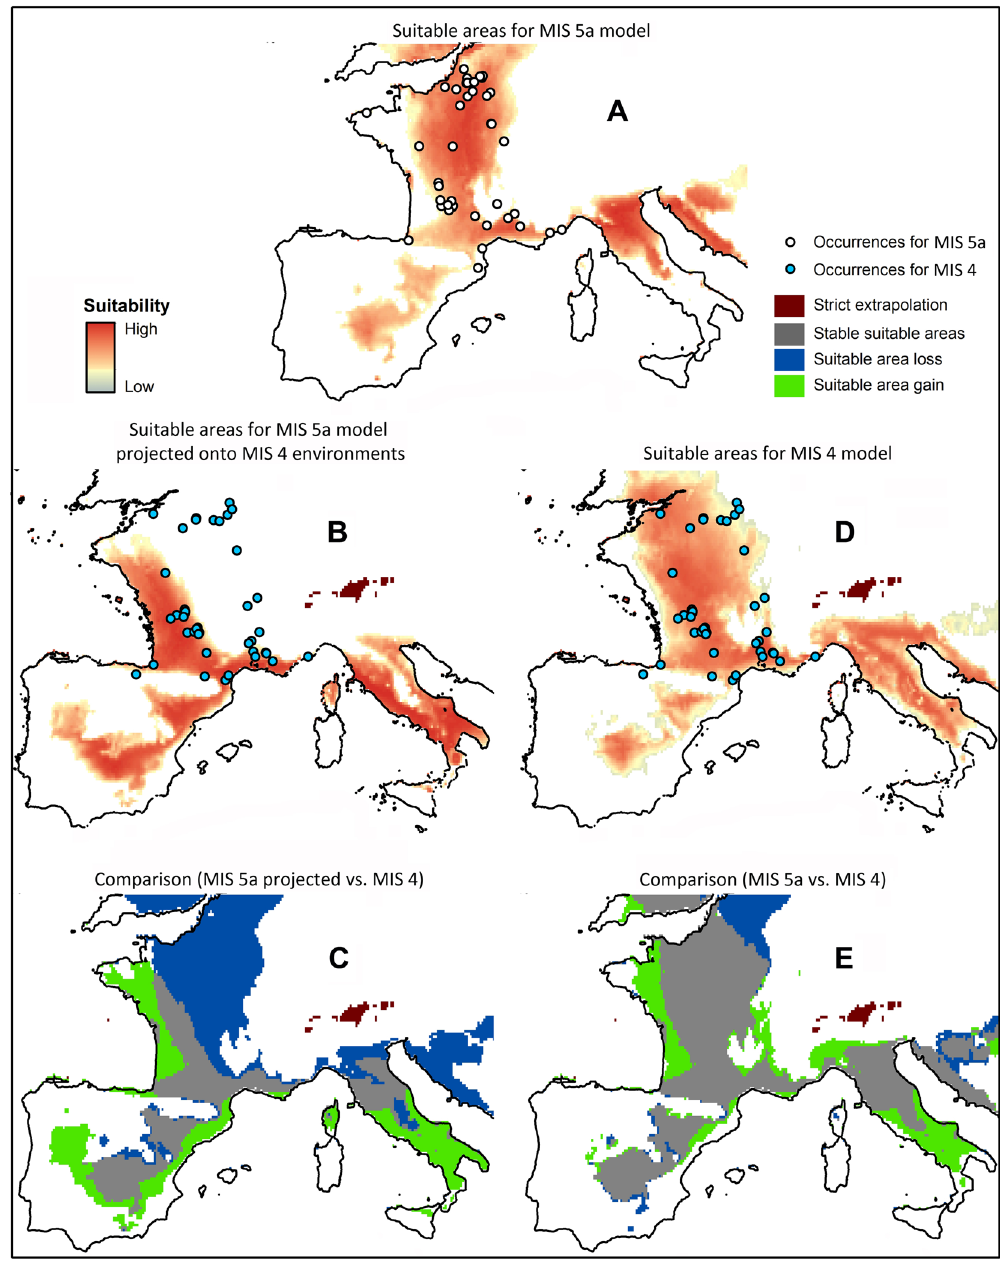
Figure 1. Geographic projections of Neanderthal ecological niche estimations produced with the kuenm R package. ( A ) Reconstructed Neanderthal niche for MIS 5a with coastlines reflecting 80 ka sea level (− 20 m) 36 ; ( B ) Neanderthal MIS 5a niche projected onto MIS 4 environmental conditions with coastlines reflecting 60 ka sea level (− 60 m) 36 ; ( C ) Comparative overlap of predicted suitable areas between the MIS 5a Neanderthal niche and the same MIS 5a niche projected onto MIS 4 environmental conditions; ( D ) Reconstructed Neanderthal niche for MIS 4; E) Comparative overlap of predicted suitable areas between the MIS 5a Neanderthal niche and the MIS 4 niche. Maps were created using ArcGIS 10.5.1 (https ://deskt op.arcgi